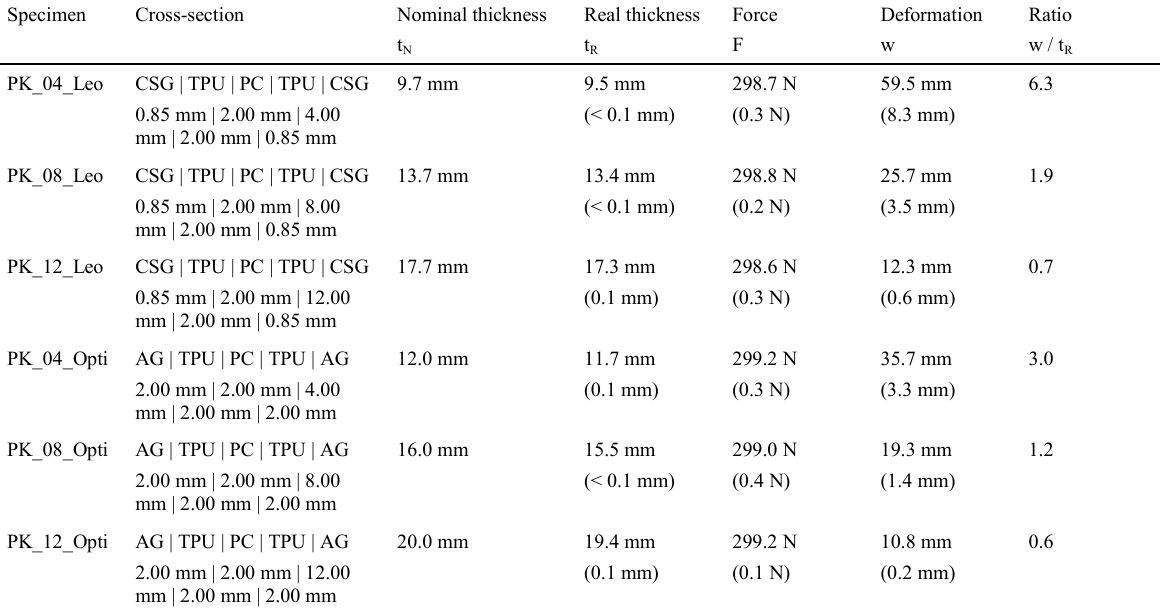
Table 2: Test results as mean values of the four-point bending test. The bracket term describes the standard deviation. Specimen